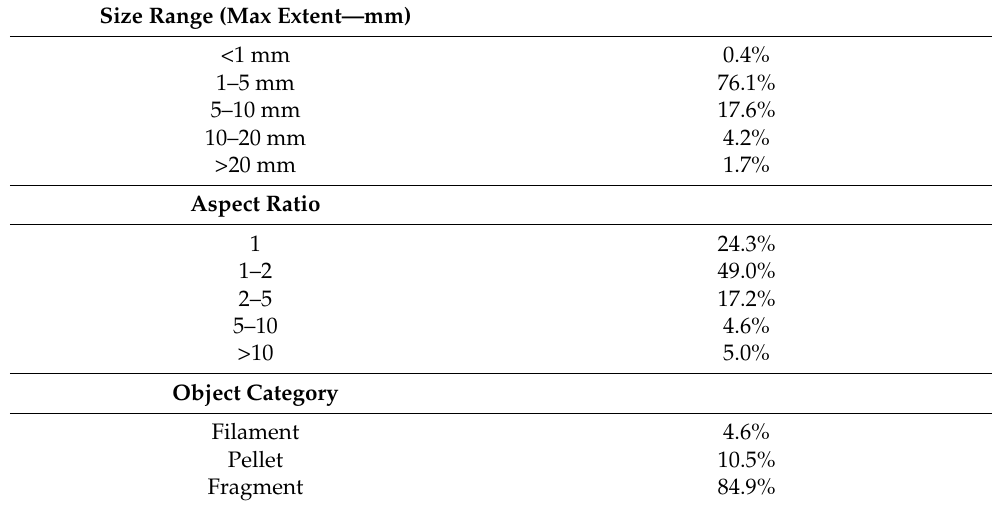
Table 1. Size, aspect ratio and category of the collected